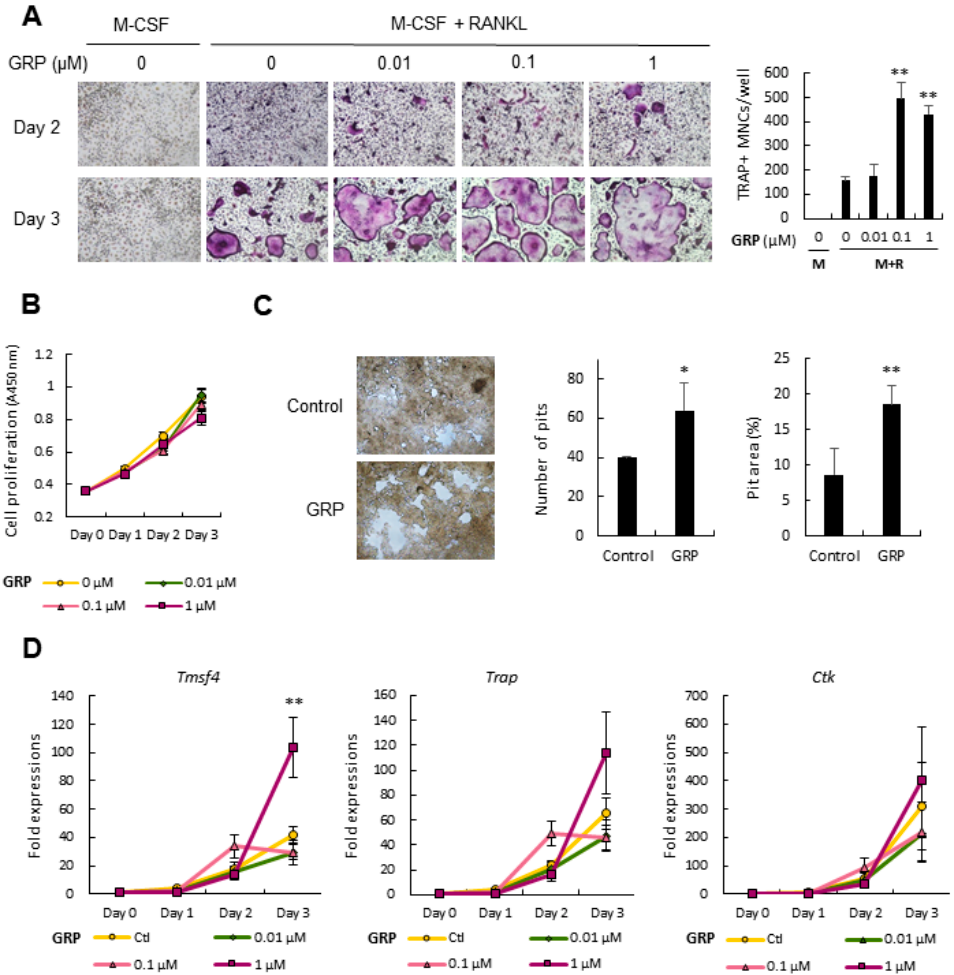
Figure 1. Gastrin-releasing peptide (GRP) treatment stimulates osteoclastogenesis. ( A ) Bone marrow-derived macrophages (BMMs) were cultured with macrophage colony-stimulating factor (M-CSF) and receptor activator of nuclear factor kappa-B ligand (RANKL) in the presence of increasing concentrations of GRP. The number of tartrate-resistant acid phosphatase positive (TRAP+) multinucleated cells (MNCs) were quantified on Day 3; ( B ) Cell Counting Kit-8 (CCK-8) assay showed that there are no significant differences in the proliferation of BMMs between groups treated with different concentrations of GRP; ( C ) On Day 8, resorption activity of osteoclasts in the presence or absence of 0.1 μ M GRP was analyzed by quantifying the number of pits the percentage of eroded area; ( D ) Quantitative real-time polymerase chain reaction (PCR) analyses of molecular markers of osteoclast fusion ( Tmsf4 ) and osteoclast differentiation ( Trap and Ctk ) through Days 0 to 3. Scale bars, 100 µm. Magnification, ×100. Quantitative data are presented as mean ± SD. * p < 0.05 and ** p < 0.01 by ANOVA test. Asterisk shows a significant difference from the control or Day 0 group.